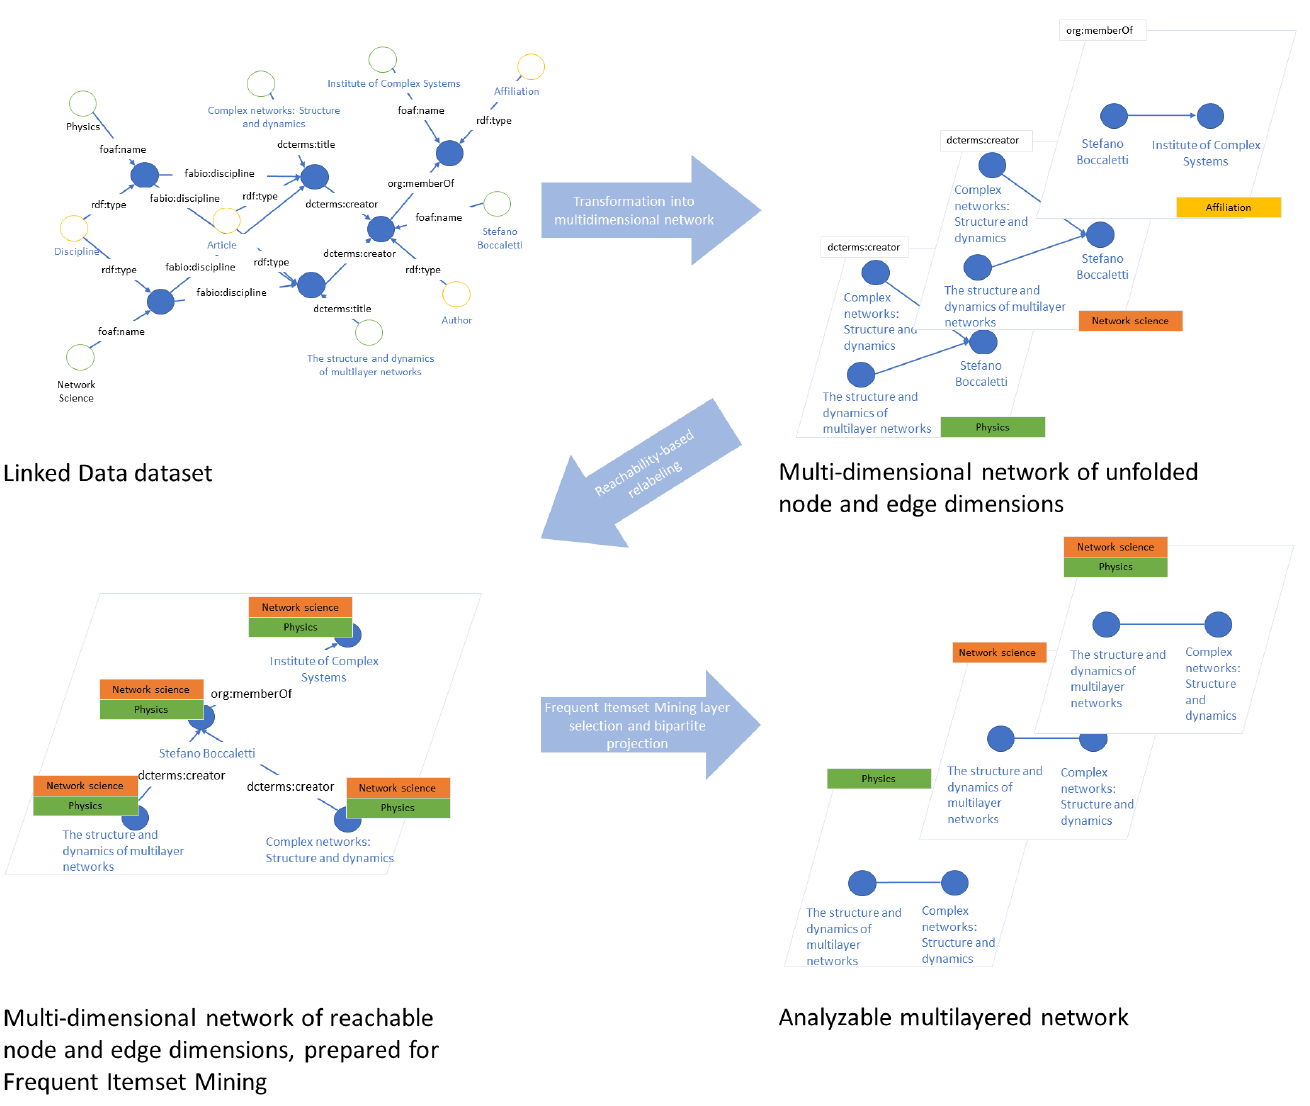
Figure 1. Workflow of the proposed network transformation steps towards an analysable multidimensional network from a linked data